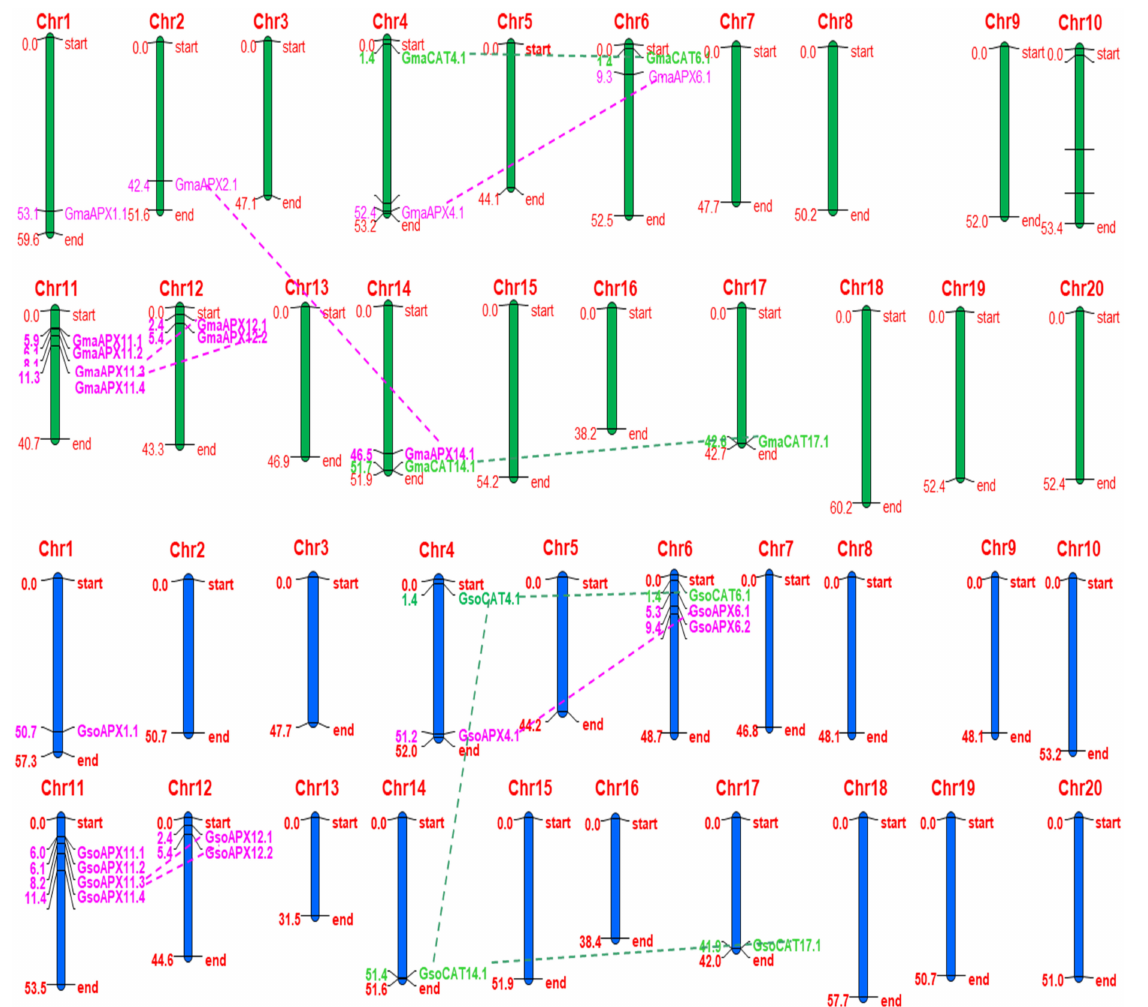
Figure 2. Chromosomal locations and gene duplication events of APX and CAT genes of G. max (green chromosomes) and G. soja (blue chromosomes). The scale on the left side of the chromosome is the position of the genes in megabases, and on the right side of each chromosome, gene names correspond to the approximate locations of each APX and CAT gene. Furthermore, the segmentally duplicated genes are connected by dashed lines represented by the same color as APX and CAT genes. Table 2. Gene duplication analysis for the APX and CAT gene families of wild and cultivated